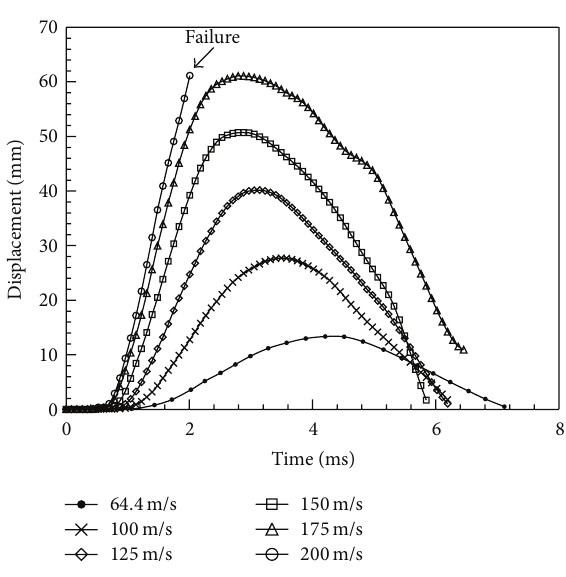
Figure 12: Displacement time plot at Location